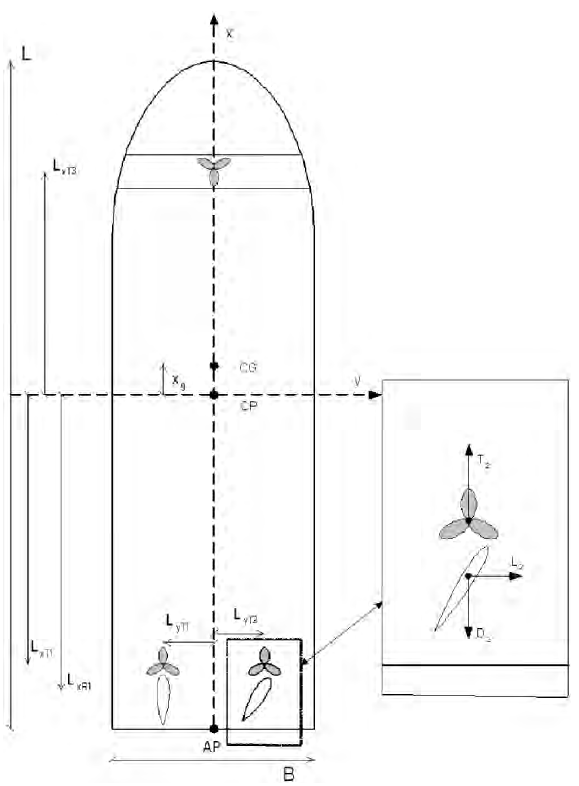
Figure 2. Actuator configuration of CyberShip